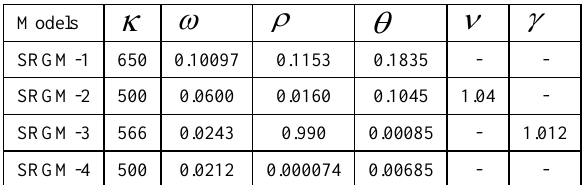
Table 3. Estimated results for data set 2